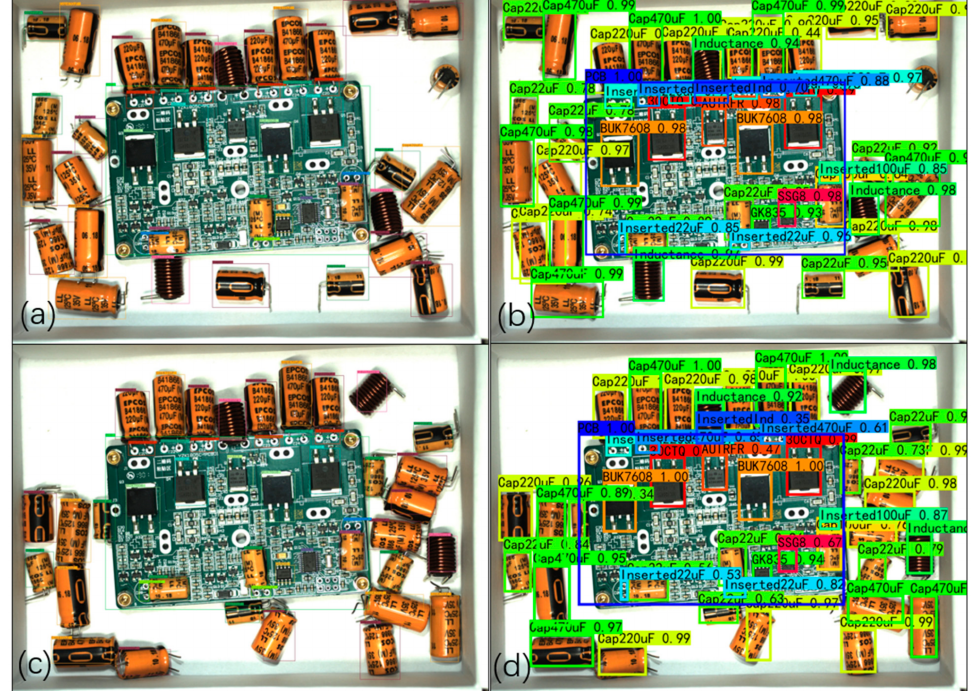
Figure 15. Object detection result after PCB assembly based on Balanced-YOLOv3 ( a ) Ground truth of original image1 after assembly ( b ) Object detection result of original image1 after assembly ( c ) Ground truth of original image2 after assembly ( d ) Object detection result of original image2 after